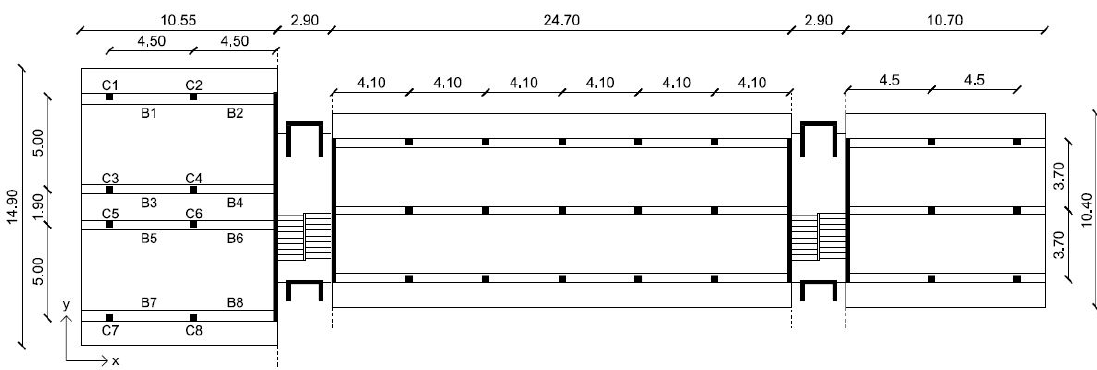
k tor r s 2 / l s 2 Variation Variation